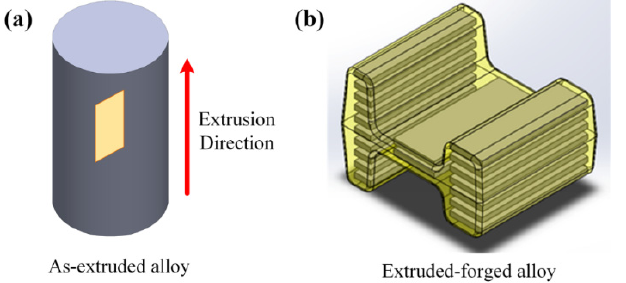
Figure 2. The schematic of alloy coupons cut from the ( a ) as-extruded billet and ( b ) extruded-forged I-beam.